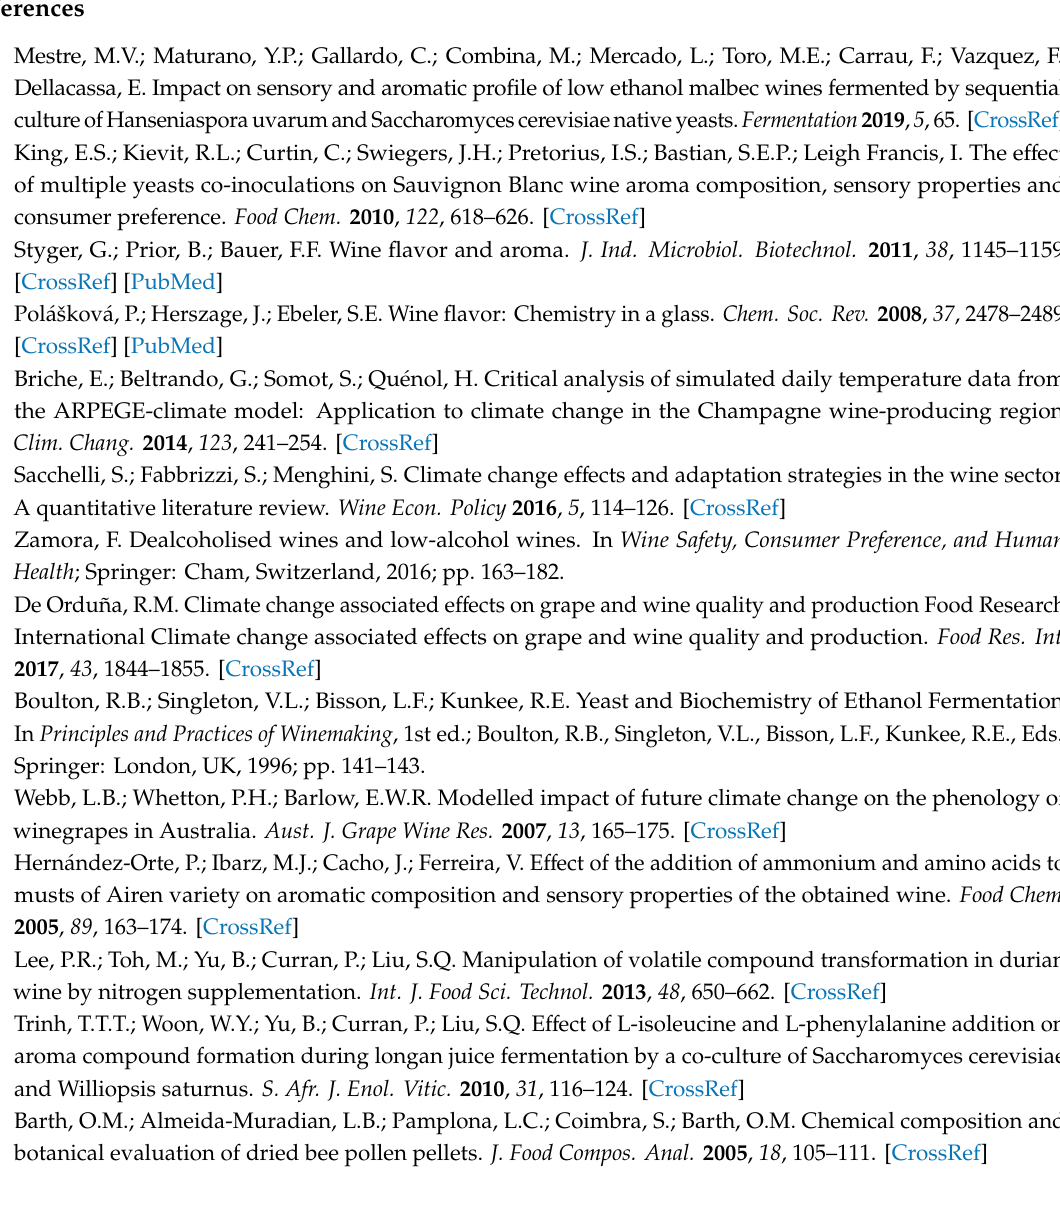
Table S1. Generic and specific olfatory attributes results of Tintilla de Rota wines sensory